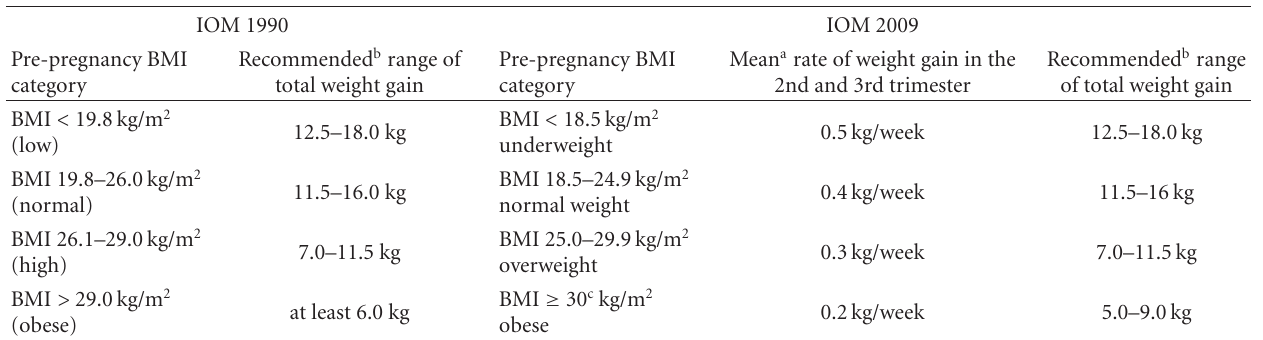
Table 1: Gestational weight gain recommendations based on the 1990 and 2009 Institute of Medicine guidelines [5,